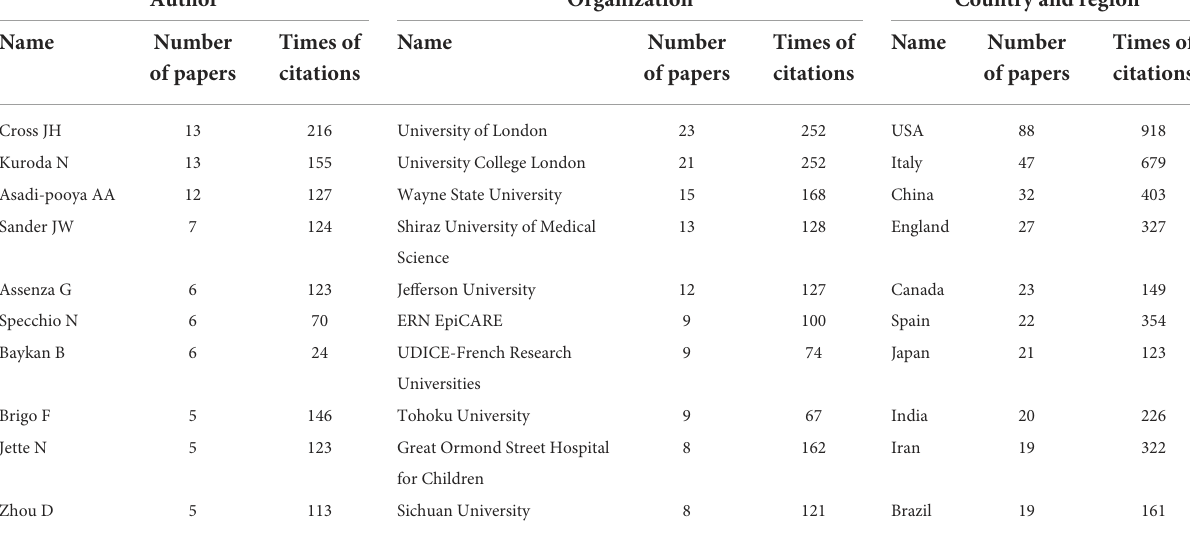
TABLE 2 Top 10 authors/organizations/countries ranked by the number of papers related to COVID-19 and